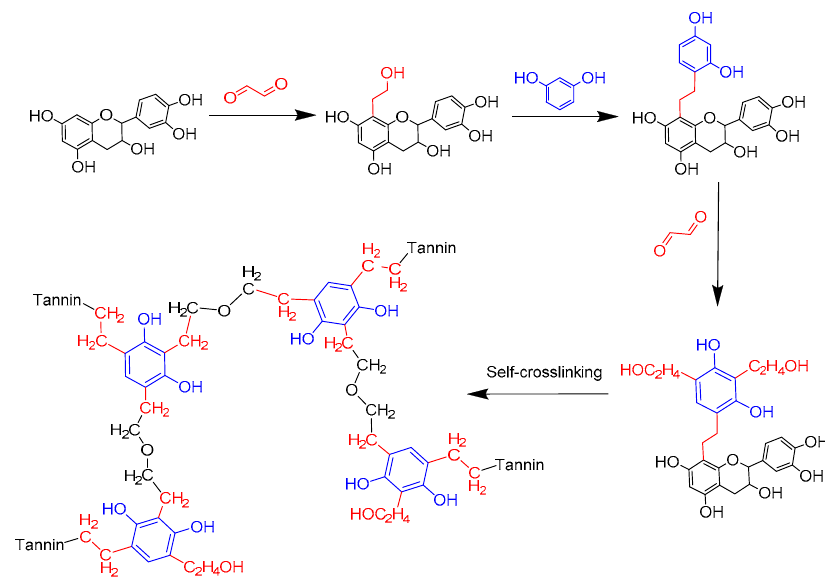
Scheme 1. The reaction process of TR.